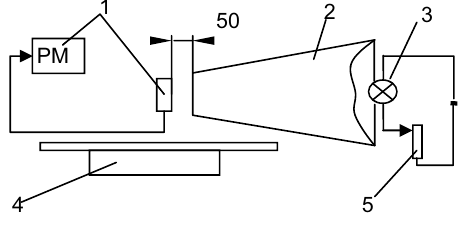
Fig. 5. Structure of experimental assembly: 1 – PA-2 sensor unit; 2 – cone; 3 – incandescent lamp; 4 – rotary table; 5–digital voltmeter